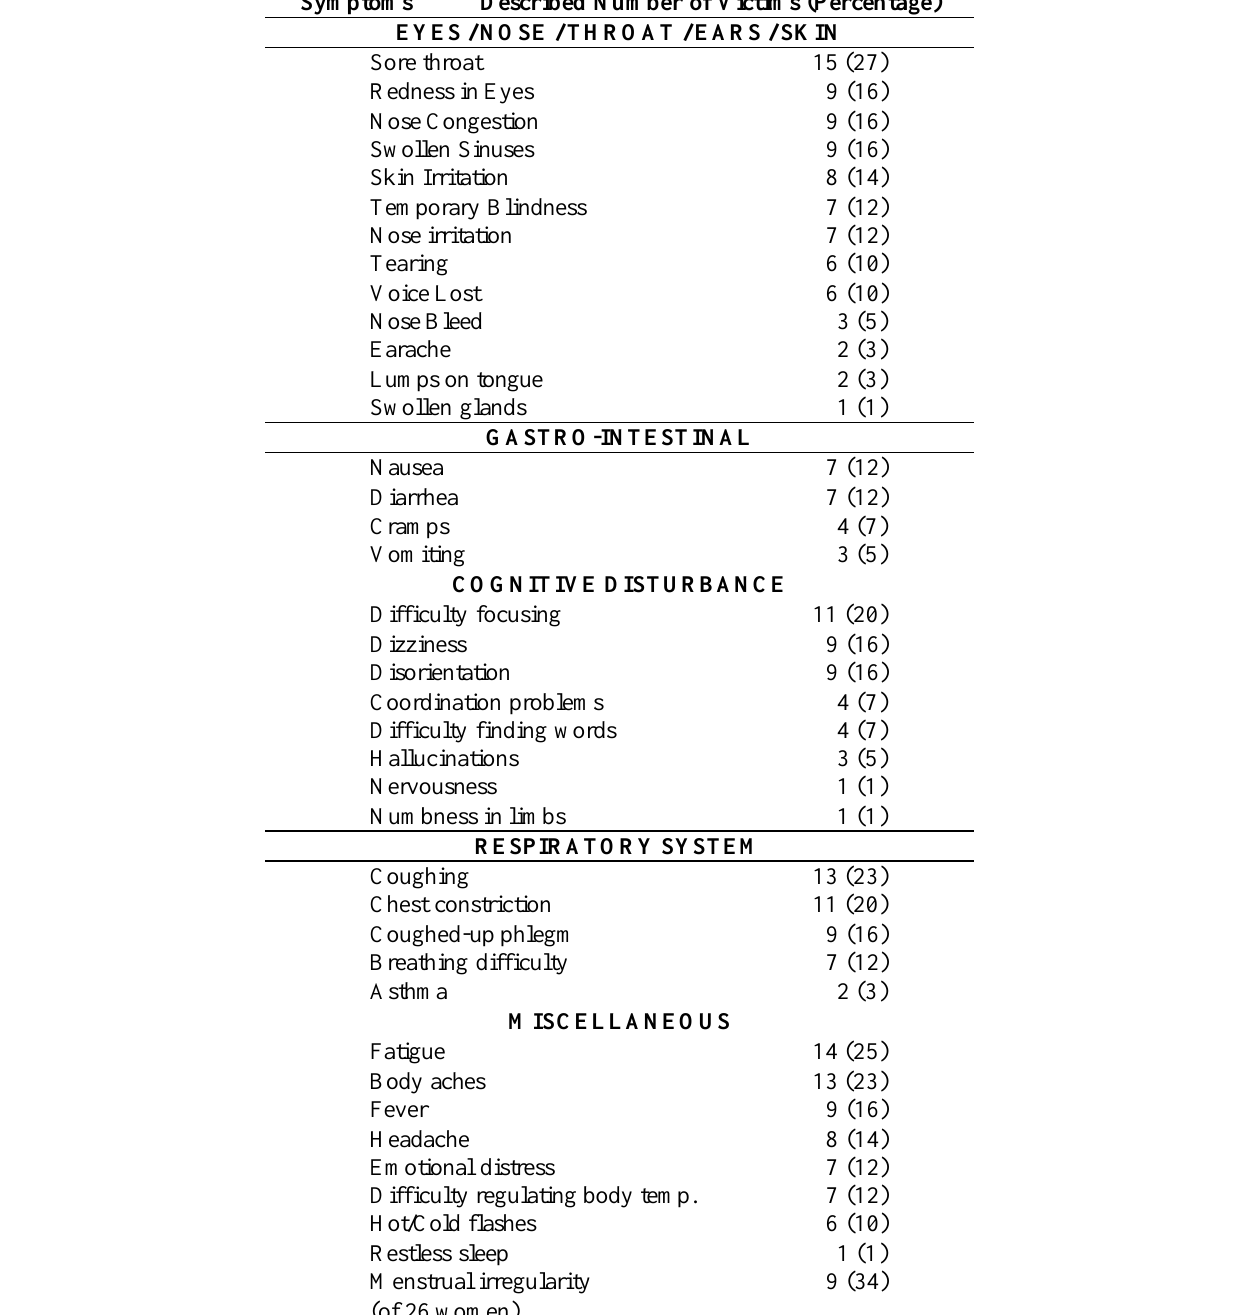
Table I : Symptoms Described by 55 Victims of Tear Gas and Pepper Spray in the Seattle WTO Protests.